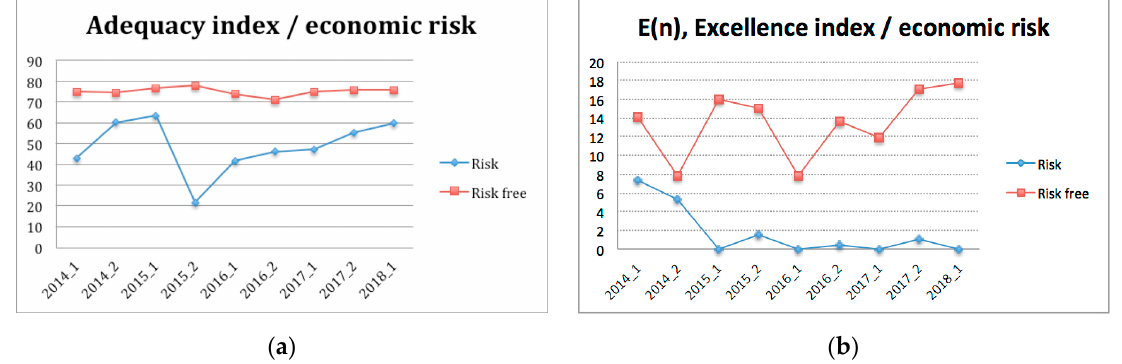
Figure 6. Adequacy ( a ) and excellence ( b ) indices, distinguished by the level of economic risk.